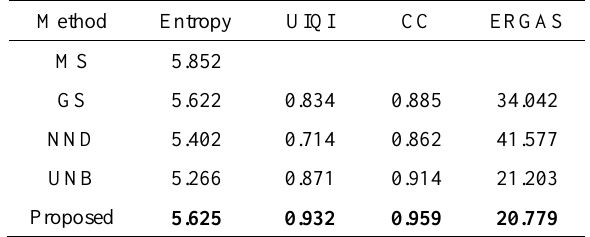
Table 2. Quality evaluation of fused images: Water body (corresponding to Figure 2). The best performance of each metric is in